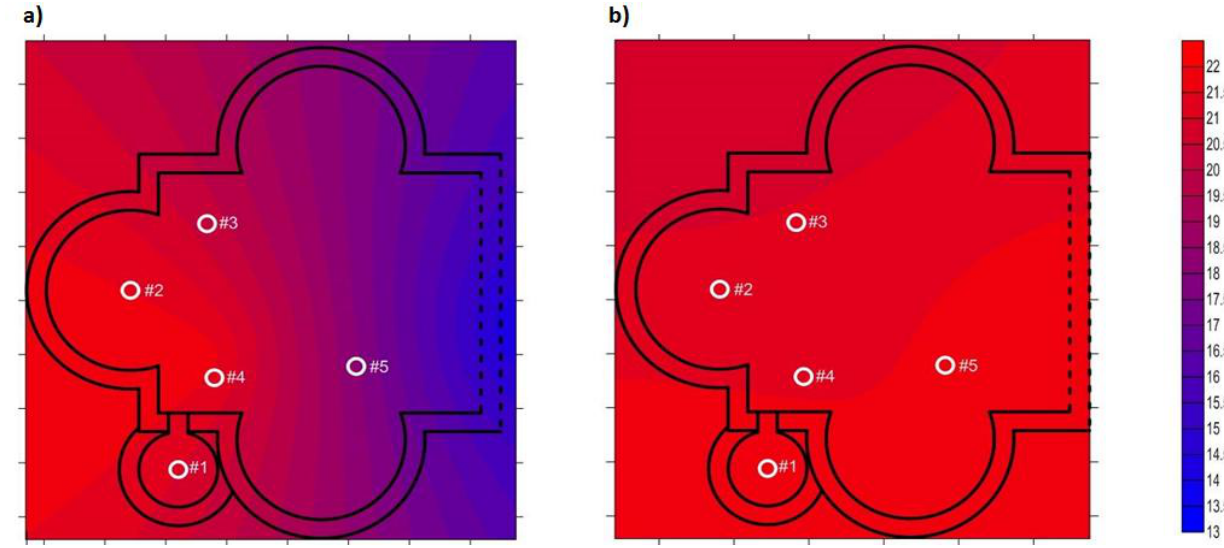
Figure 7. Contour plots of water vapour pressure (mbar), ( a ) for data recorded from 25 July 2013 to 12 August 2013 (864 data points/sensor); ( b ) for data recorded from 13 August 2013 to 8 October 2013 (2,688 data